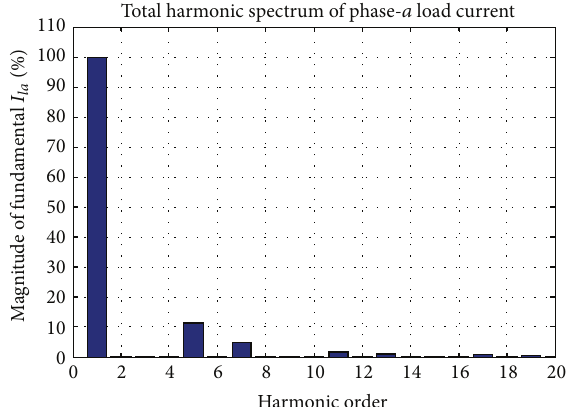
Figure 10: Frequency spectrum of phase- a load current.